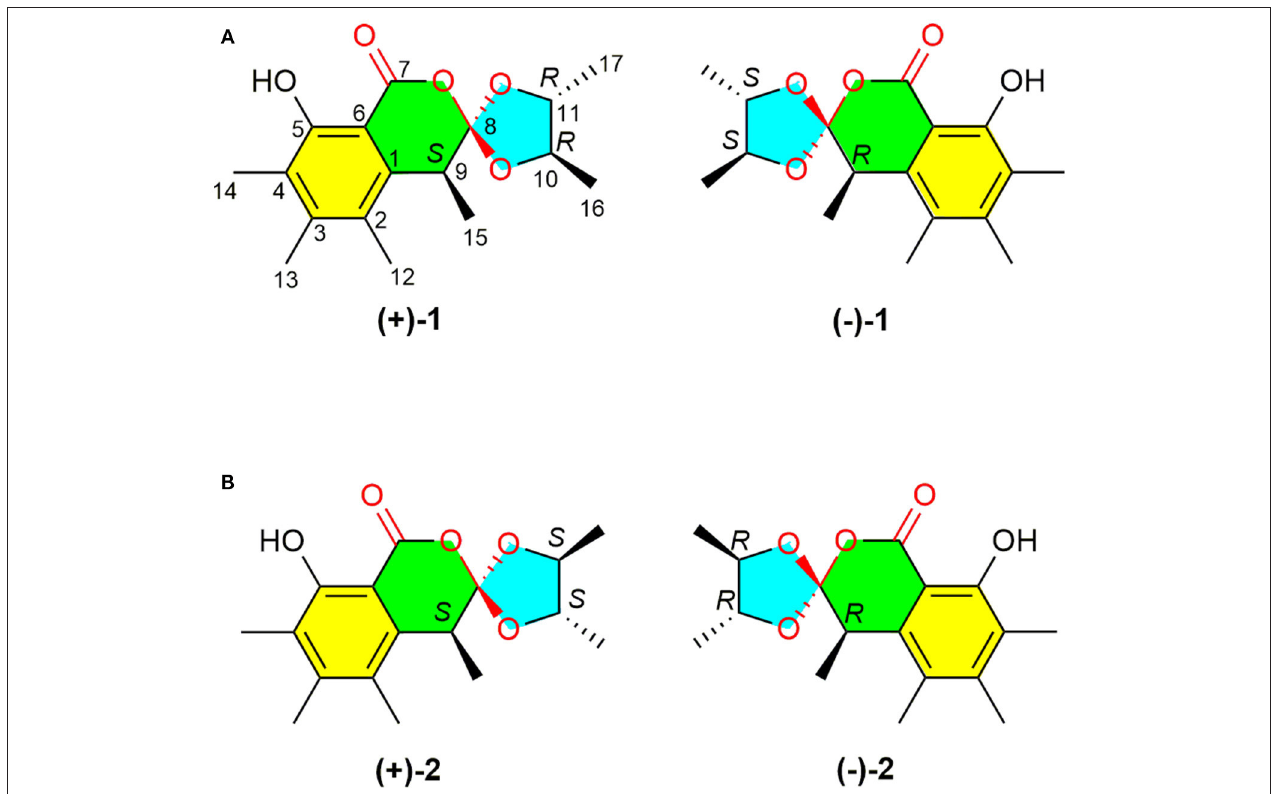
FIGURE 1 | Structures of ( ± )-peniorthoesters A ( ± 1 ) and B ( ± 2 ).